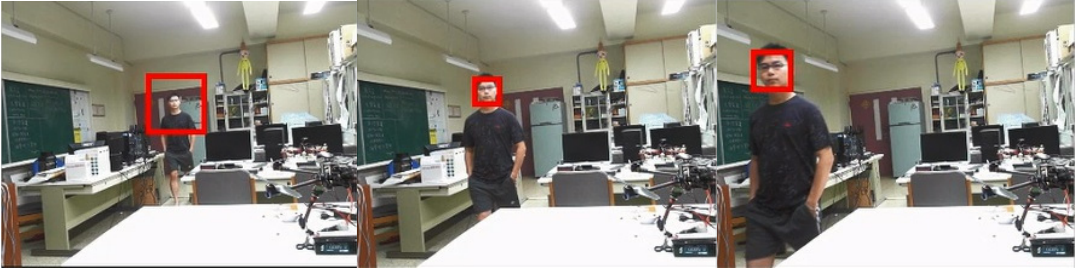
Figure A1. The real-time face detection of a dynamic object.